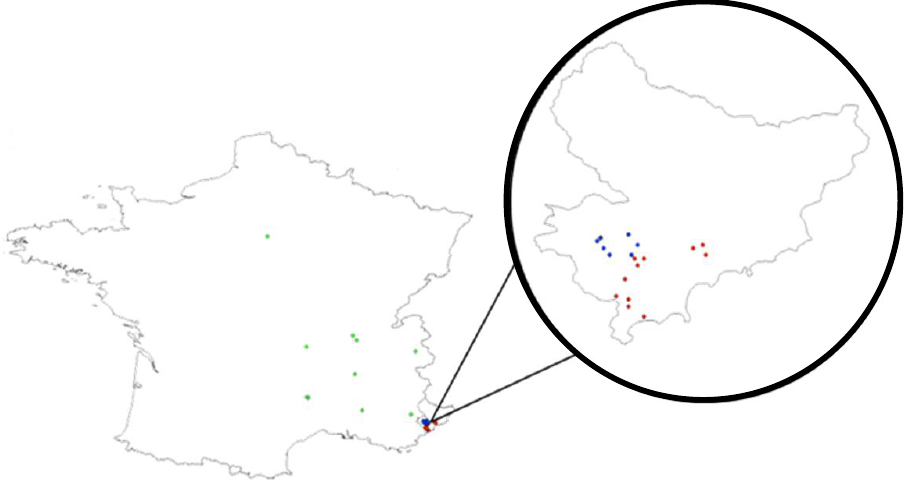
Figure 1. Map of the strains used this study. Left: overall view. Right: zoom of the French department, “Alpes-Maritimes”. The three strains’ origins are visualized as follows: meso-editerranean in red, supra-Mediterranean in blue and northwestern in green.